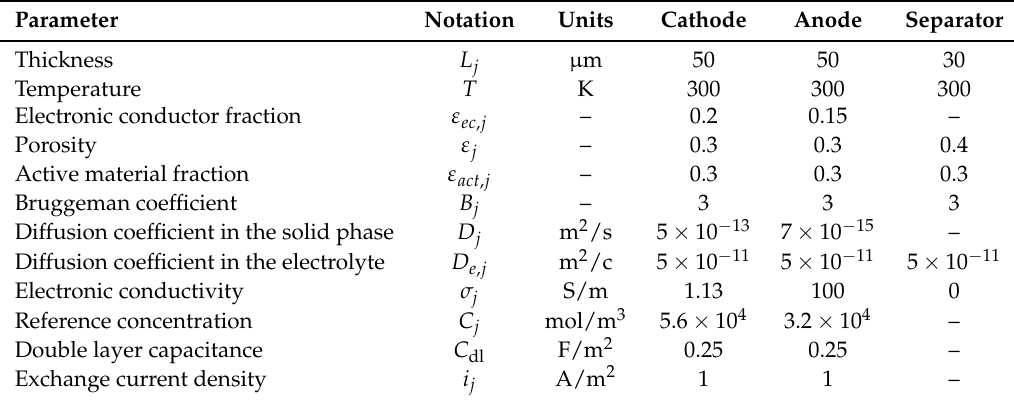
Table 2. Basic parameters of the Abraham, Kawauchi, and Dees